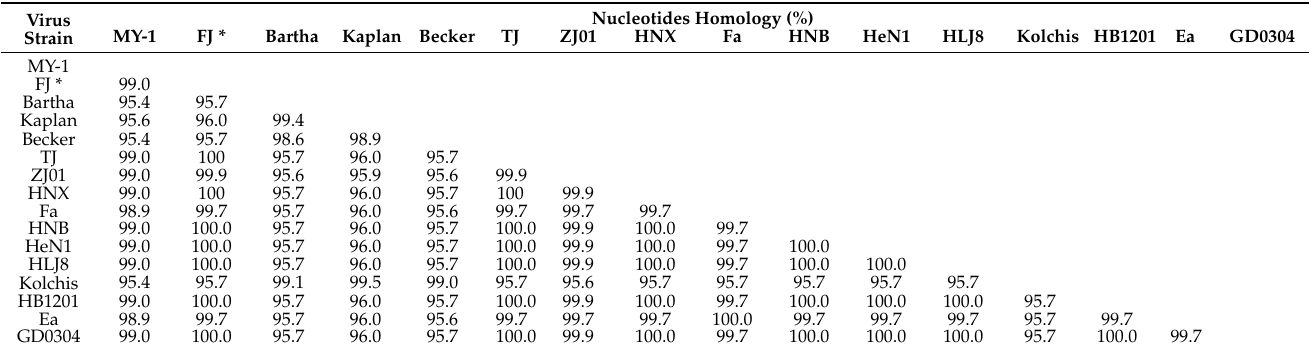
Table 4. Complete gene sequence nucleotide homology analysis.